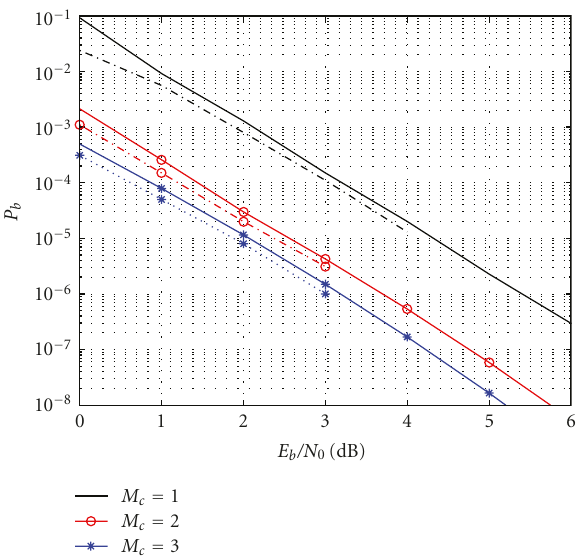
Figure 4: Bit-error probability of convolutionally coded GSC with M = 4 in Nakagami fading with m = 0 . 75 (solid: bound, dashed: simulation).